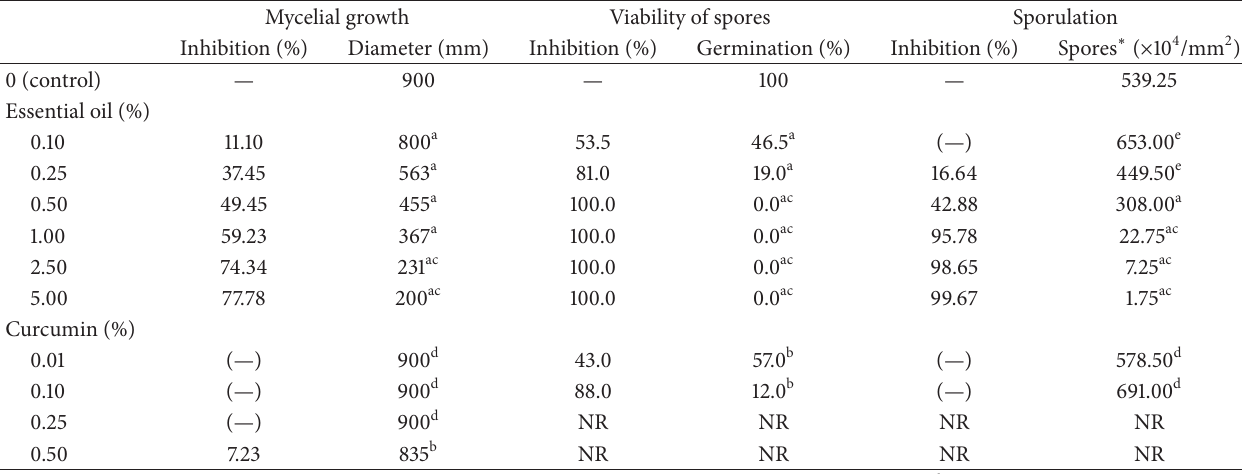
Table 2: Inhibitory effect of Curcuma longa L. essential oil and curcumin on Aspergillus flavus Link growth, viability of spores, and sporulation in vitro